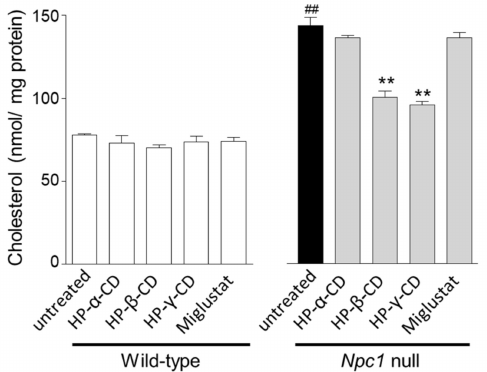
Figure 2. E ff ects of cyclodextrins (HP- α -CD, HP- β -CD, and HP- γ -CD) and miglustat on cellular free cholesterol levels in WT and Npc1 -null CHO cells. Cellular free cholesterol levels were measured 24 h after exposure to cyclodextrins (1 mM) or miglustat (100 µ M). Each bar represents the mean ± S.E.M. ( n = 3); ## p < 0.01 compared with the WT group, ** p < 0.01 compared with the untreated Npc1 -null